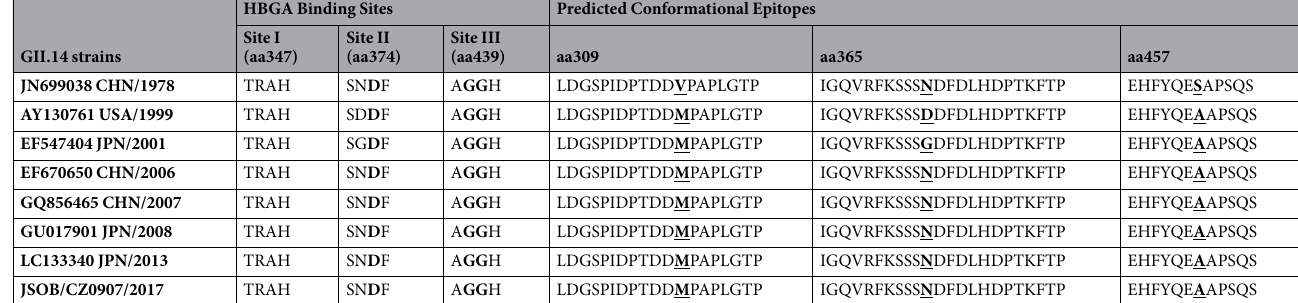
Table 2. The sequence analysis of HBGA binding sites and predicted conformational epitopes of GII.14 VP1 protein. The HBGA-binding interfaces are composed of three amino acid motifs that are indicated with sites I, II, and III. The predicted conformational epitopes are also composed of three amino acid components with residues, bold and underlined, that indicate changes. Numbers indicate the starting position of amino acid components, which is located on the norovirus HK74 genome (GenBank accession No.